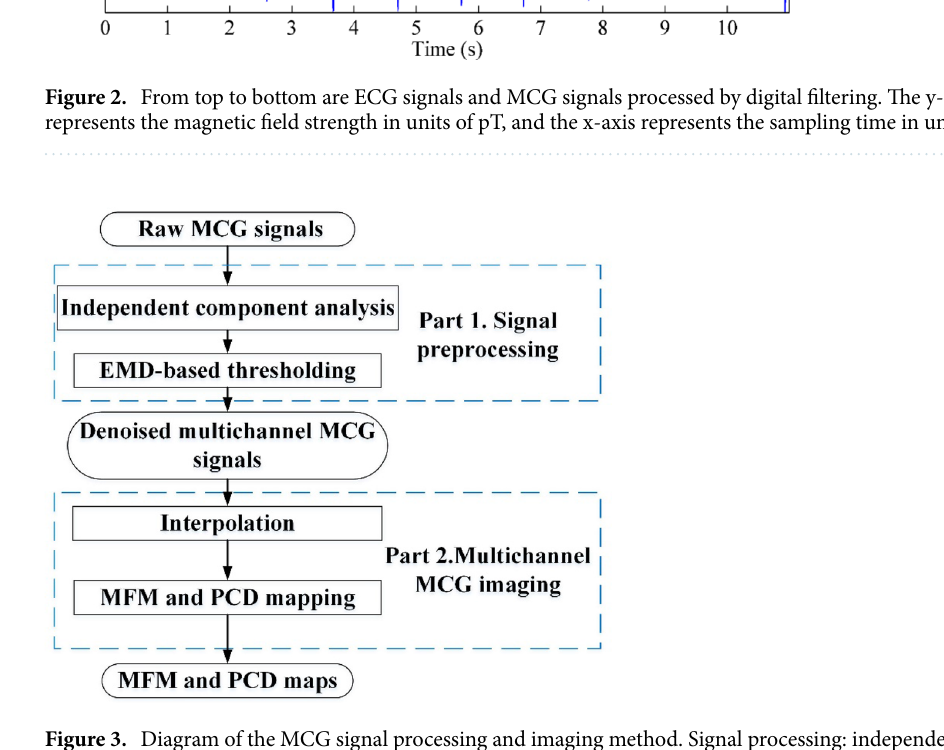
Figure 3. Diagram of the MCG signal processing and imaging method. Signal processing: independent component analysis and empirical mode decomposition (EMD). After processing the signal, through cubic spline interpolation, the representation is magnetic field maps (MFM) and pseudocurrent density (PCD)